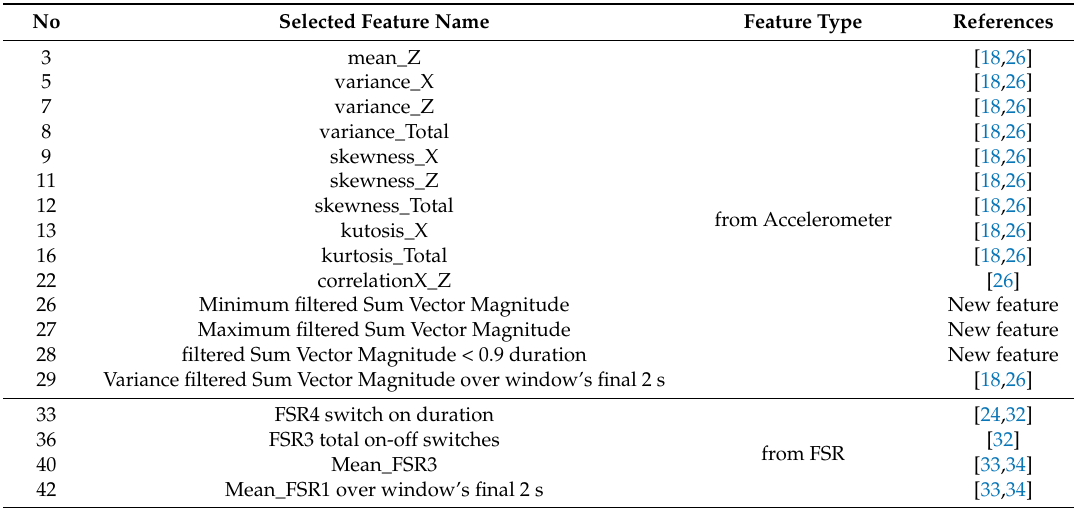
Table 4. Selected features for optimal fall